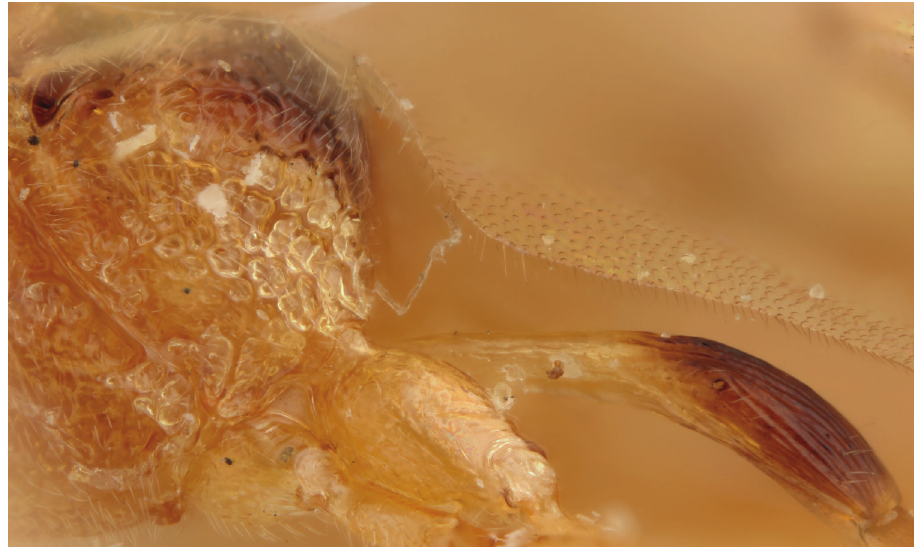
Figure 4. Perilitus mylloceri paratype female, propodeum and first metasomal